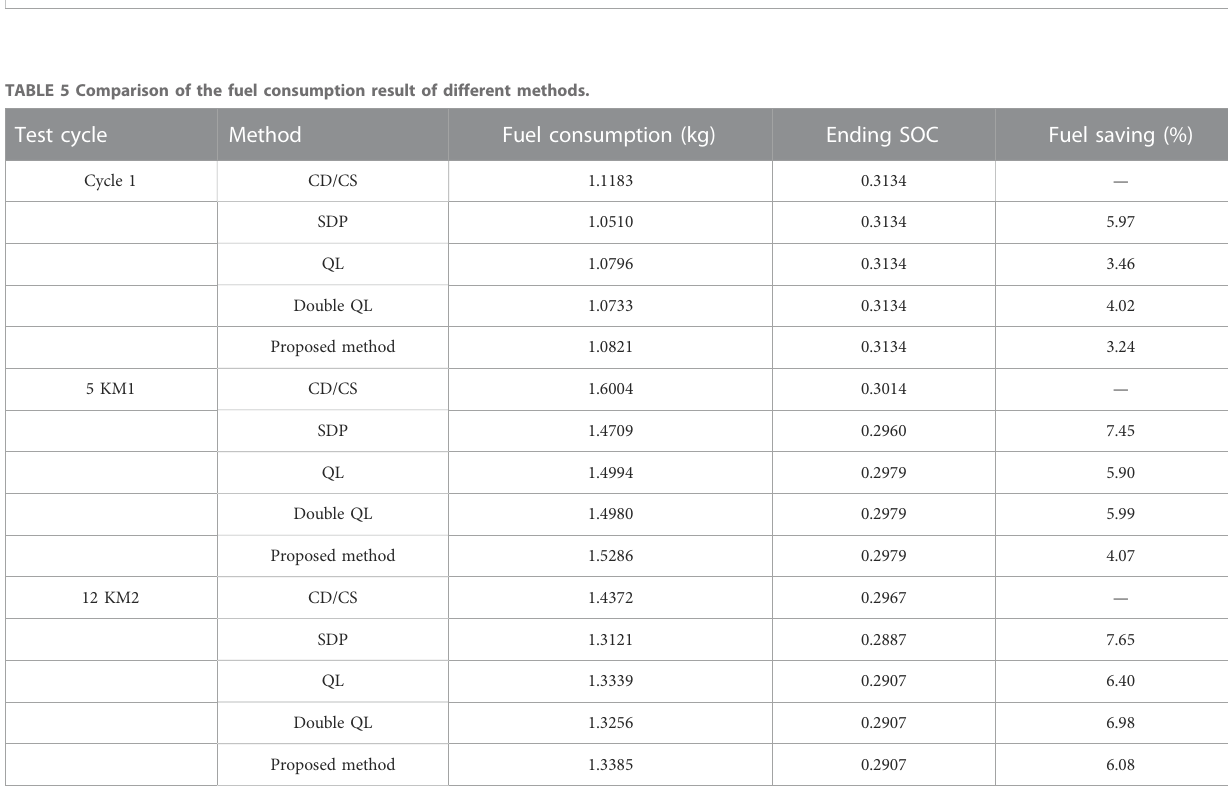
FIGURE 12 Test cycles: (A) Cycle 1; (B) 5 KM1; (C) 12 KM2.